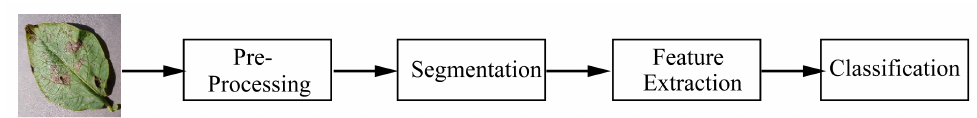
Figure 2. Basic handcrafted-features-based steps for